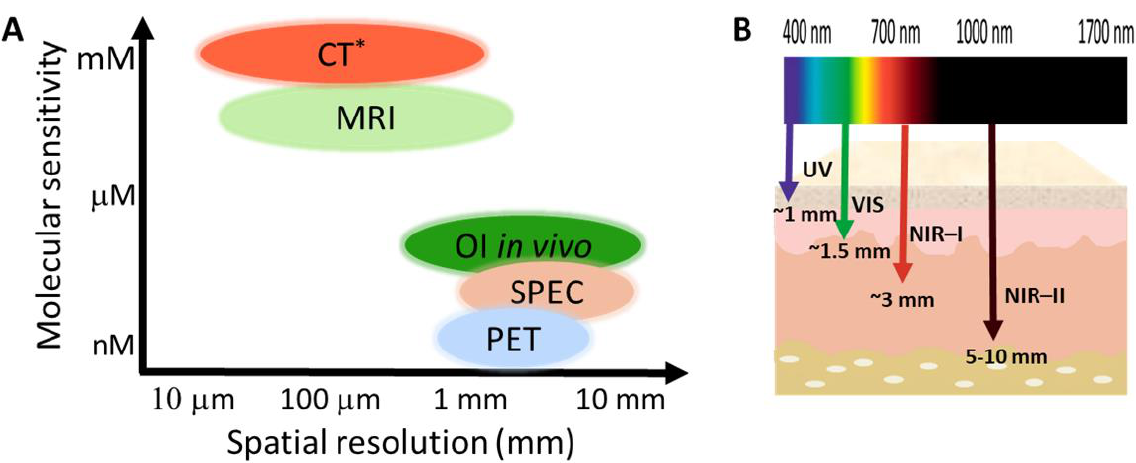
Figure 2. ( A ) The molecular sensitivity and spatial resolution of imaging processes of relevance to this review, * sensitivity not well characterised. Data obtained from [17–19]. ( B ) Schematic of penetration depth at varying wavelengths.